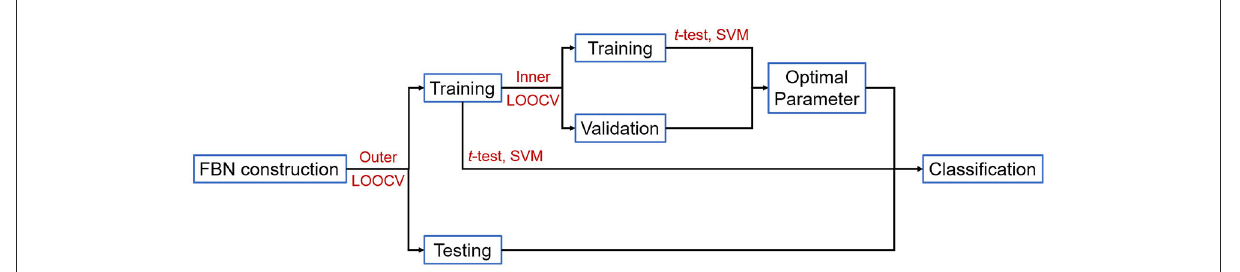
FIGURE1 Experiment procedure based on the estimated FBNs.